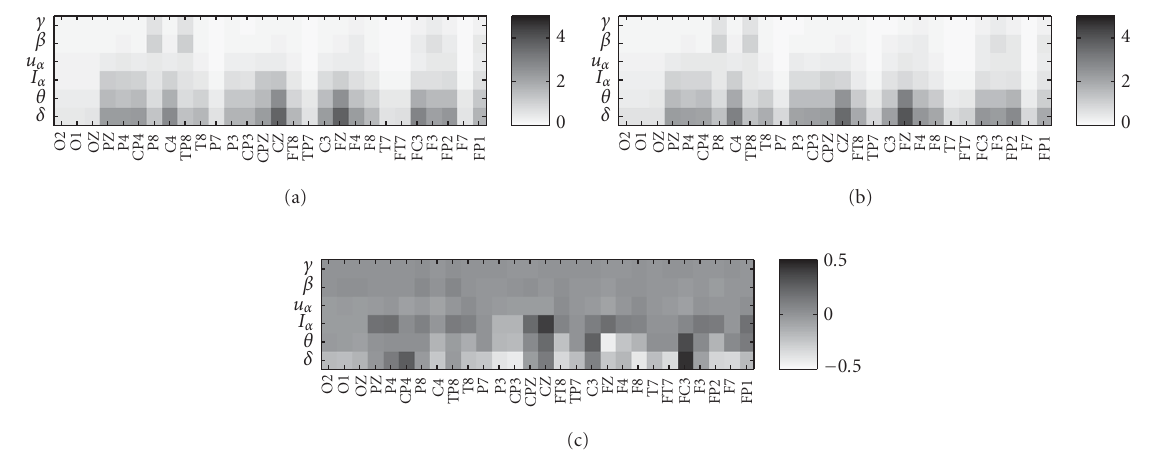
Figure 7: Median feature values for the two kinds of trials. (a) “Yes”, (b) “no”, and (c) di ff erence values for subject 6, original spectra features. Bars on right show normalized spectral power (or power di ff erence, for “yes” −